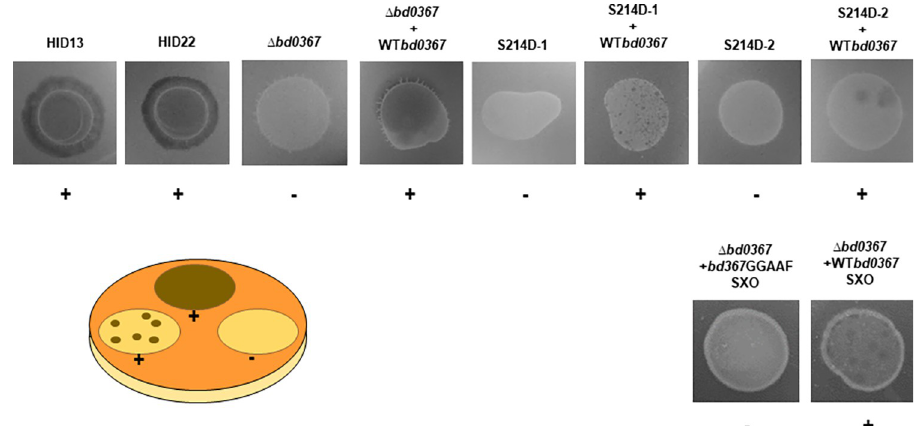
Fig 5. Plaque assay. Spots of host-independent (axenic) B . bacteriovorus cultures OD 600 1.0 on YPSC agar E . coli S17-1 prey overlay plates, incubated for 2 weeks. Two wild type host-independent B . bacteriovorus strains were tested (HID13 and HID22), alongside the B . bacteriovorus Δ bd0367 deletion strain, the bd0367 (S214D) site-directed mutant (two isolates–S214D-1 and S214D-2) and the corresponding wild type complemented strains ( Δ bd0367 + WT bd0367 , S214D-1 + WT bd0367 and S214D-2 + WT bd0367 ).). Complementation with a GGAAF mutated genotype as a single crossover was also tested ( Δ bd0367 + bd0367 GGAAF SXO) and its positive control complemented strain ( Δ bd0367 + WT bd0367 SXO). Prey killing can present itself in a number of ways in this assay, such as individual plaques, or large areas of prey clearing ( + ). Strains unable to kill prey showed a region of HI cell growth with no clearing ( - ). The numbers of experiments and plaques observed are presented in Fig E in S1 Text